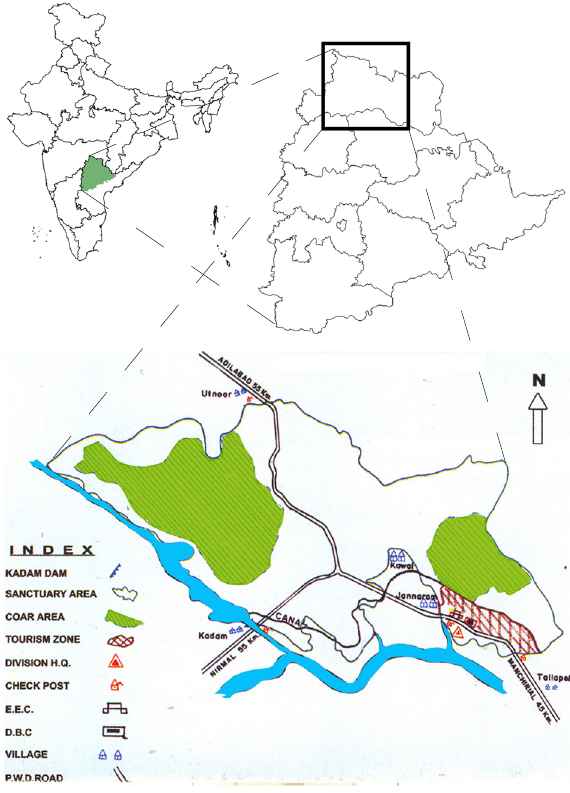
Figure 1. The Kawal Wildlife Sanctuary,